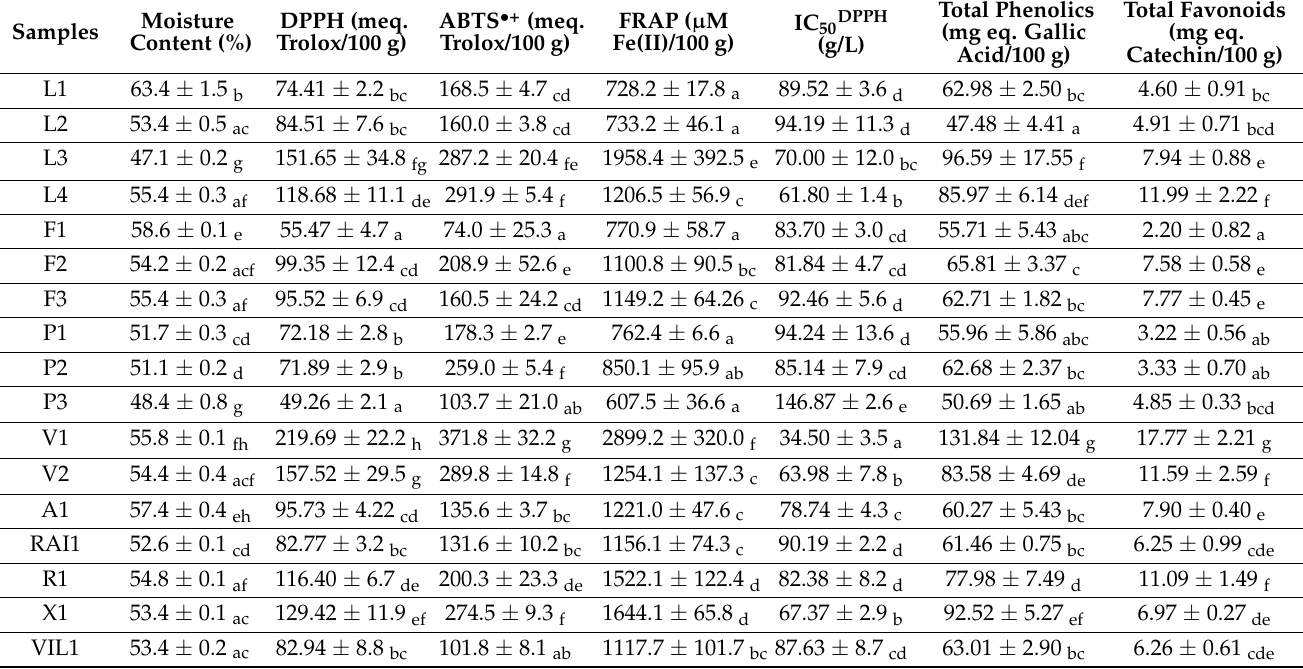
Table 2. Moisture content, antioxidant activities, total phenolic content and total flavonoids of the different chestnut